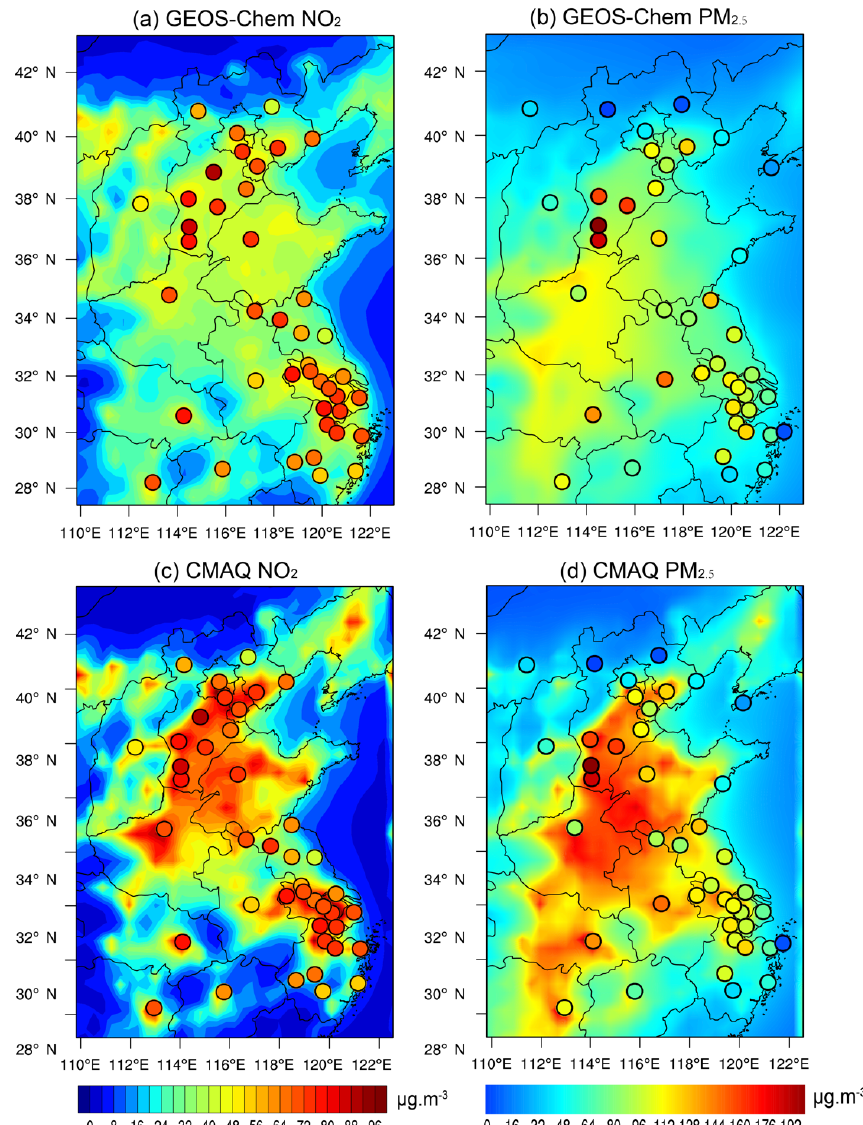
Figure 5. Observed (filled circles) and modeled (color maps) NO 2 and PM 2 . 5 averaged over 25 October–25 December 2013. Here the model results are averaged over all days rather than sampled at times of valid